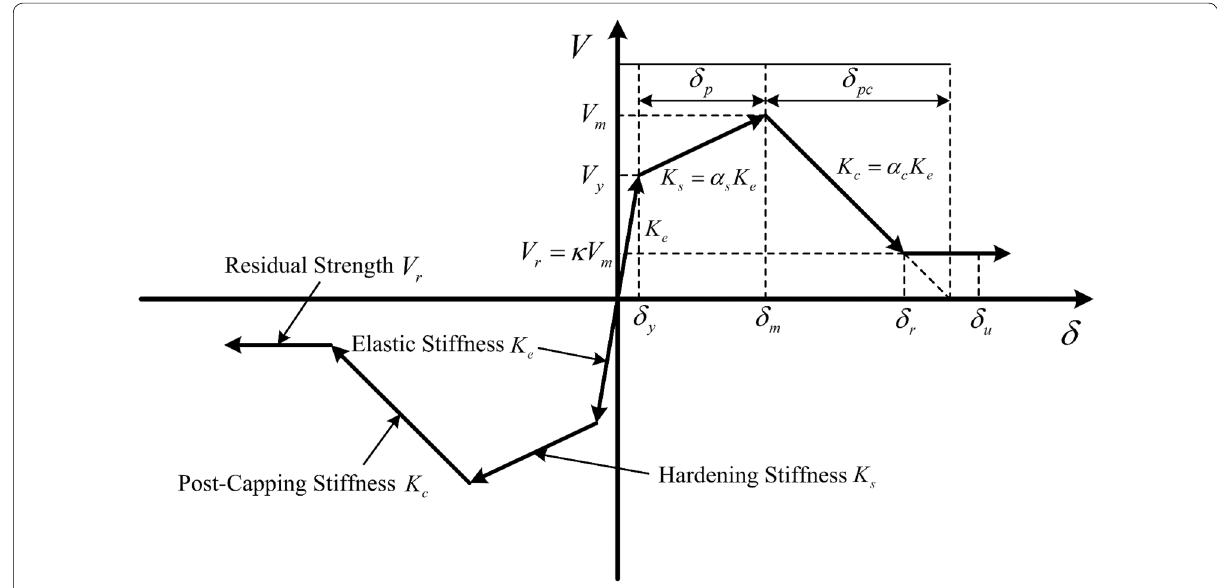
Fig. 10 Backbone curve for IKP model